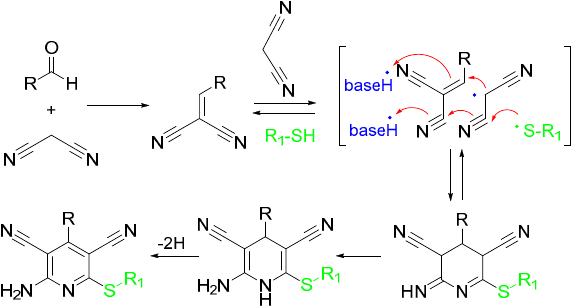
Figure 4. Reaction mechanism of the single-step, three-component reaction formulated by Evdokimov.